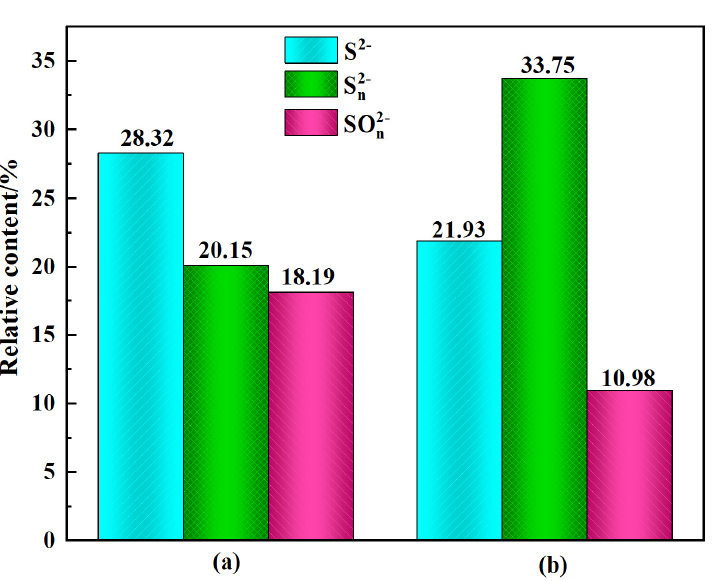
Figure 10. Relative atomic concentrations of S species treated with different samples: ( a ) cerussite + Na 2 S, ( b ) cerussite + Pb 2+ + Na 2 S.